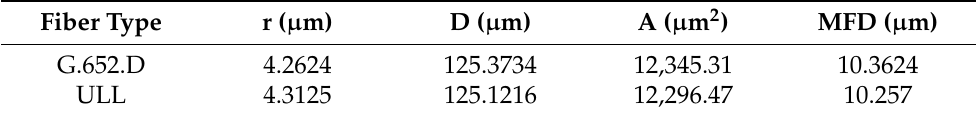
Table 1. Optical fiber characteristic